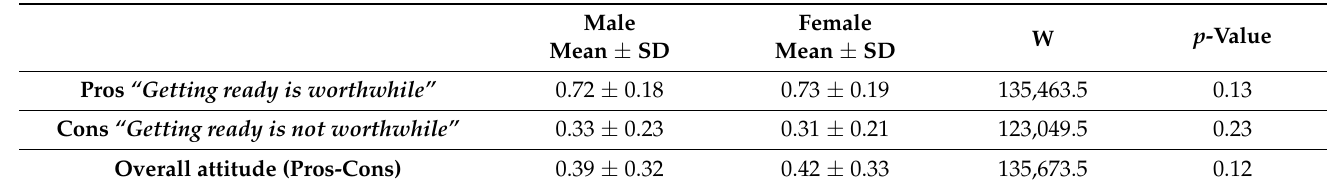
Table 7. Two-sided Wilcoxon rank sum test results for the attitudes of males and females